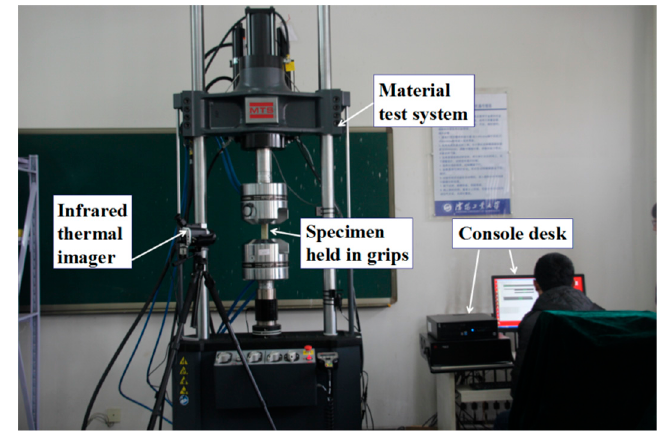
Figure 2. Experimental setup.